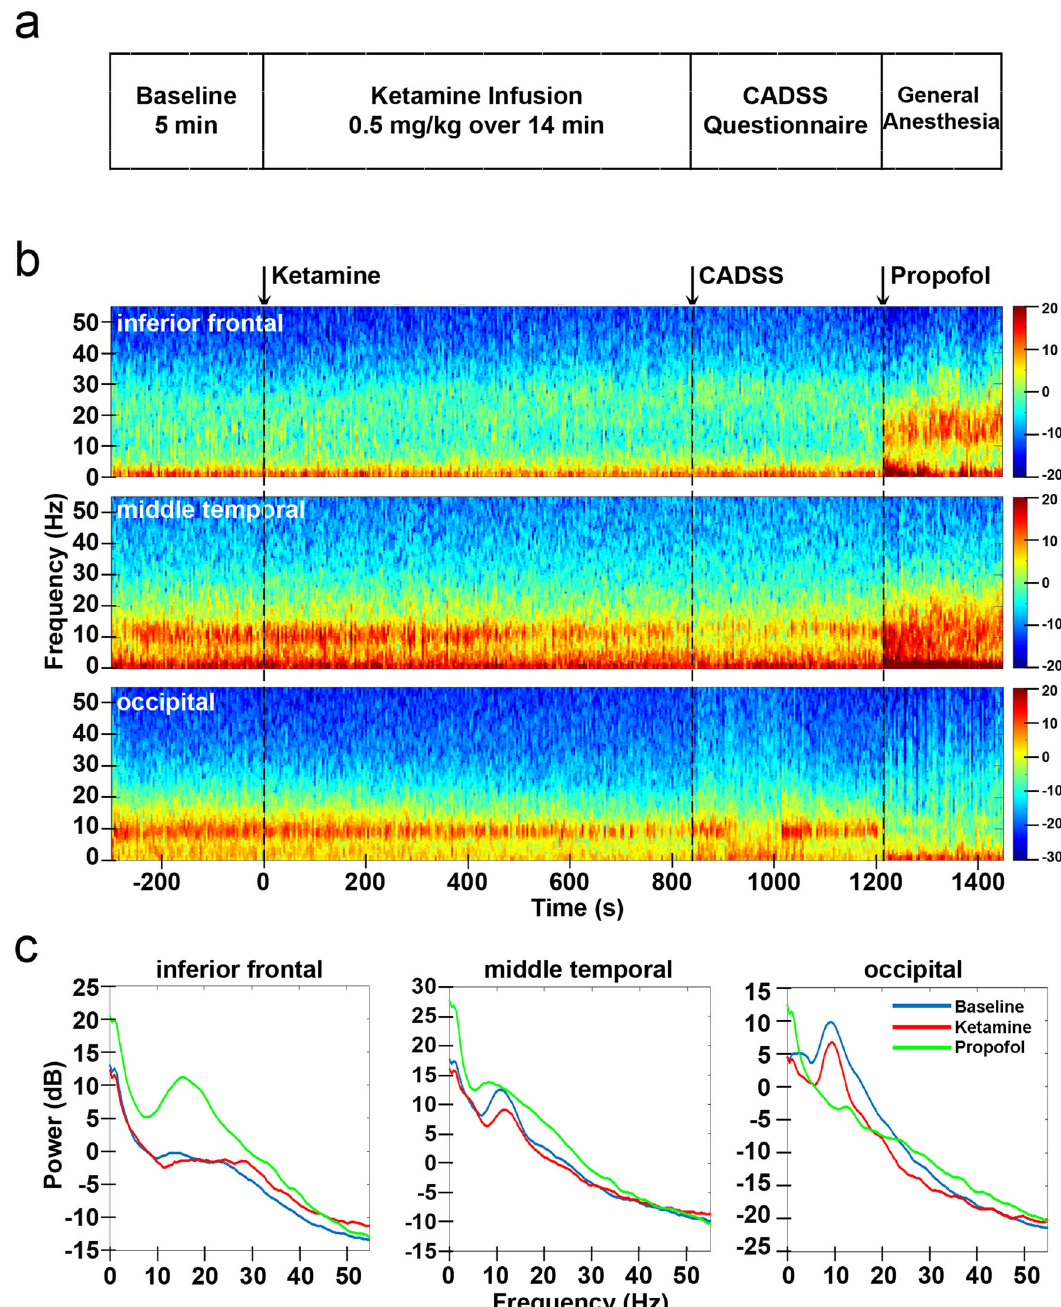
Fig. 1 | Study protocol and intracranial EEG power changes for example chan- nels. a Study protocol. b Power spectrogram (dB) for three example channels: inferior frontal, middle temporal and occipital from Subject #9. c Power spectrum